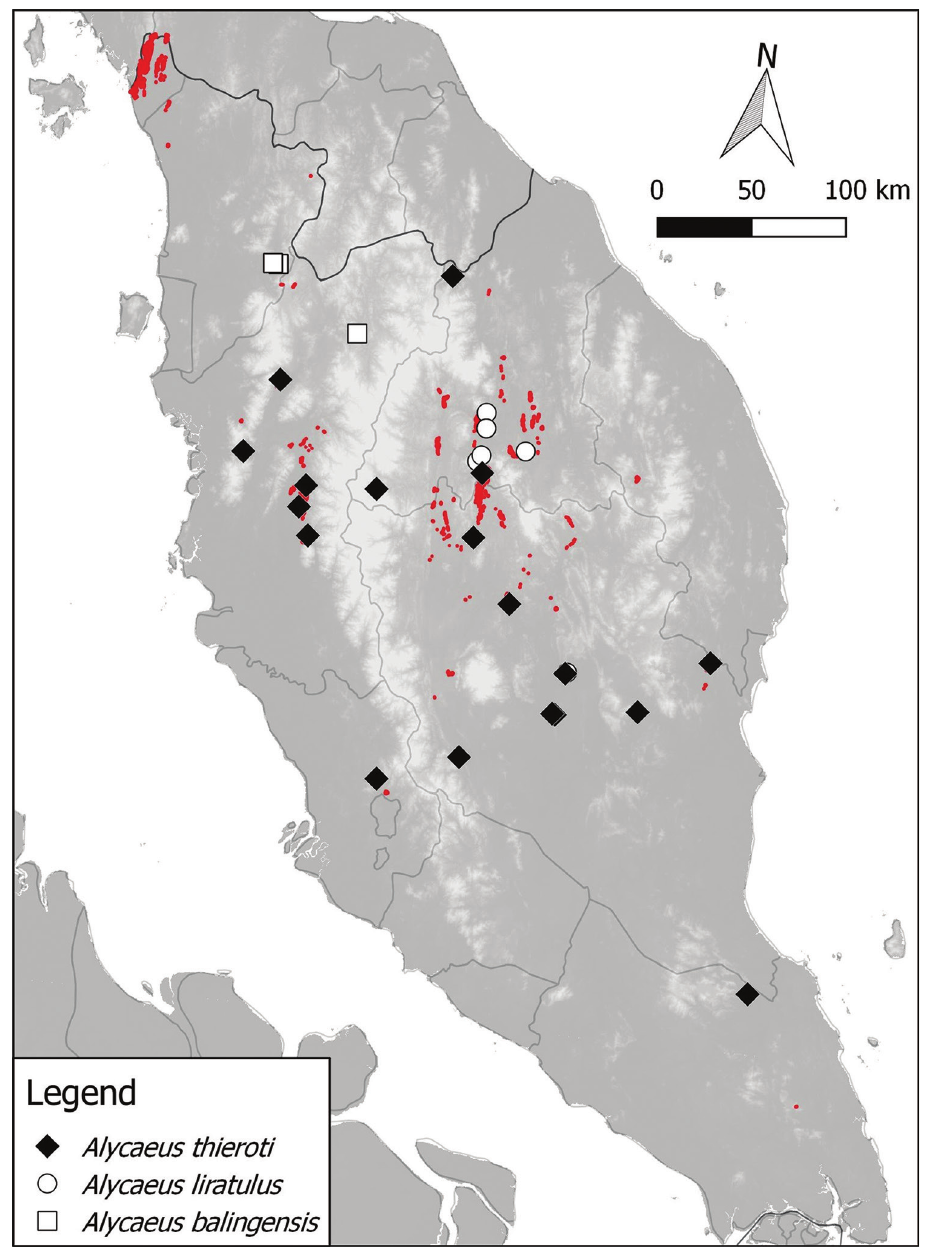
Figure 3. Distribution of 3 Alycaeus species in Peninsular Malaysia based on materials examined. Note the red areas are limestone karsts (derived from Liew et al.